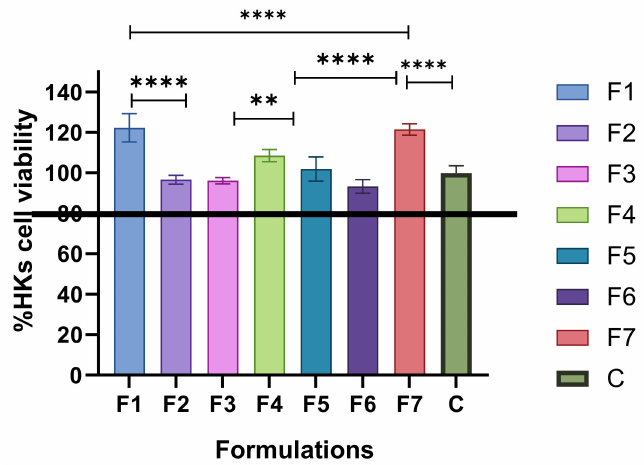
Figure 3. Cell viability of p(HEMA) hydrogel as control (C) and the drug -loaded hydrogels. Values shown represent the mean ± SD, n = 5, ** p < 0.01, and **** p < 0.0001, significant difference between formulations. The black lines marks the 80% viability where less than 80% is considered